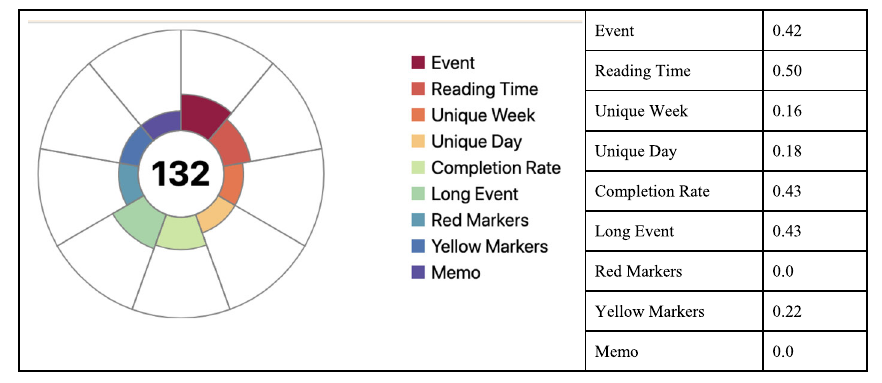
Fig. 11 Engagement score of wanderer